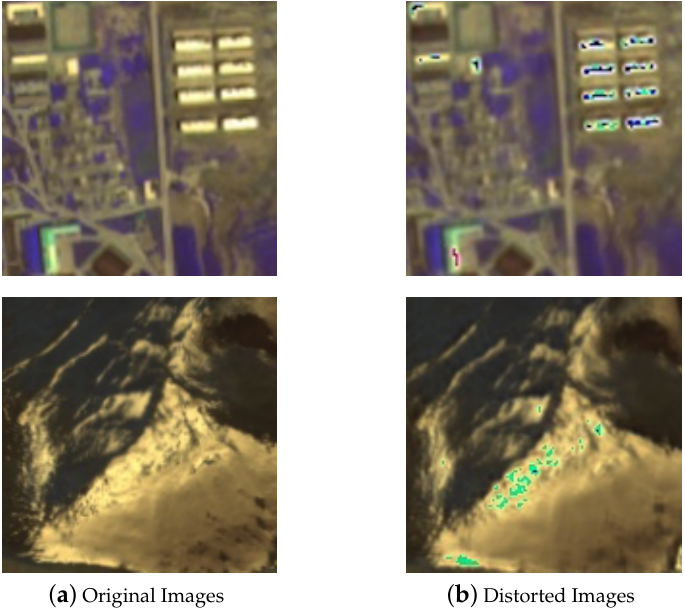
Figure 1. Examples of spectral distortion in GF-1 and GF-2 MS images: ( a ) The original images without spectral distortion. ( b ) The distorted multi-spectral images generated by